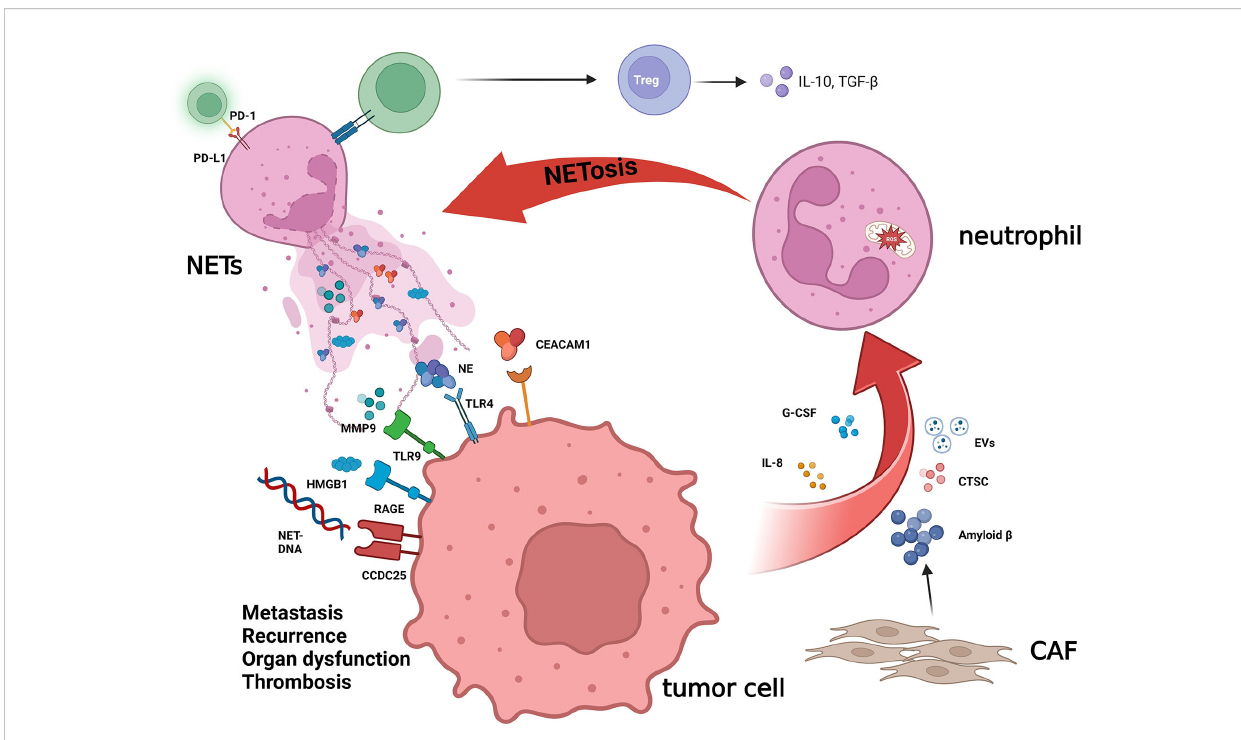
FIGURE 2 The crucial role of NETs in cancer biology. NETs, a net-like structure produced by neutrophils, play an important role in TME, which can in fl uence cancer biology by cross-talking with tumor cells. NET-DNA, which is the main component of NETs, can interact with CCDC25 on the cytomembrane of tumor cells and then activate the ILK- b -Parvin pathway to promote cell motility. NETs are decorated with HMGB1, and RAGE is the major receptor for HMGB1 in mediating sterile in fl ammation. The NE, MMP9, and CEACAM1 released by NETs trigger the TLR-4 and TLR-9 receptors on cancer cells, accelerating the growth, metastasis, and recurrence of the tumor by altering the metabolism and “ waking up ” dormant tumor cells. Other components in the TME also have a mutual effect with NETs. The amyloid b derived from CAF and other factors produced by tumor cells, including IL-8, G-CSF, CTSC, and EVs, will increase the level of NETs. NETs can also promote the differentiation of Treg cells and affect the immune-modulating function of T